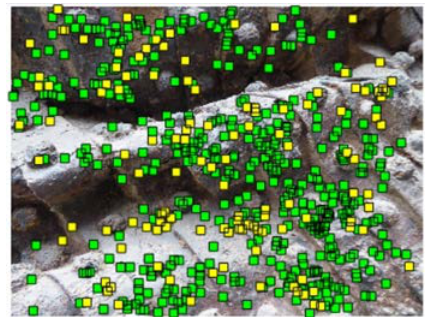
Figure 9. Example of a picture with the relative tie points.